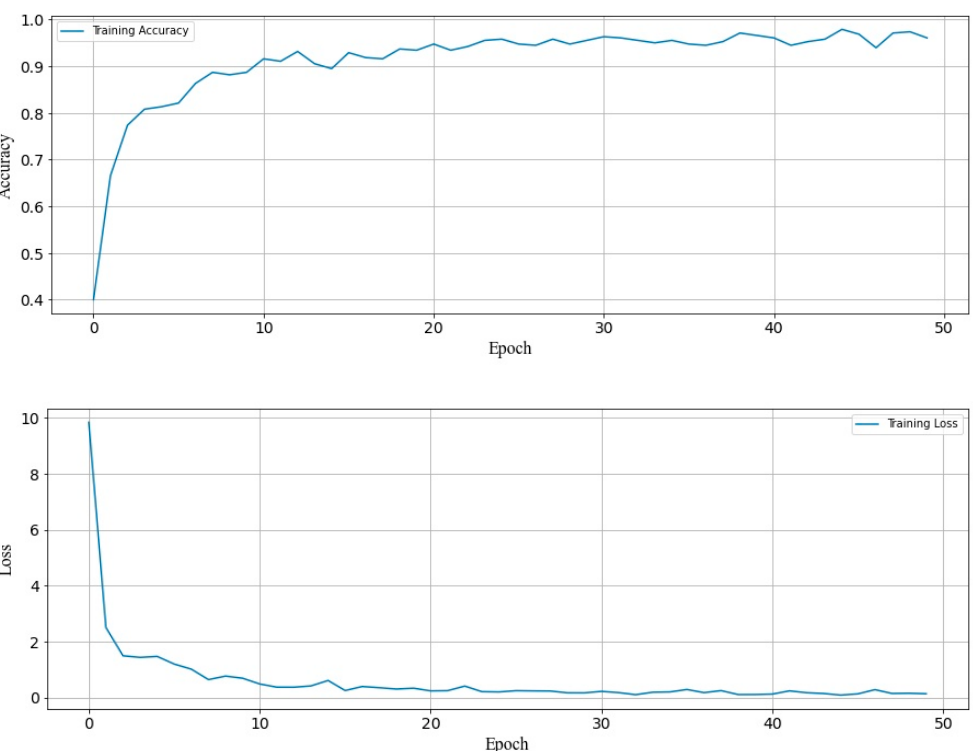
Figure 13. Accuracy and loss after training 50 times.